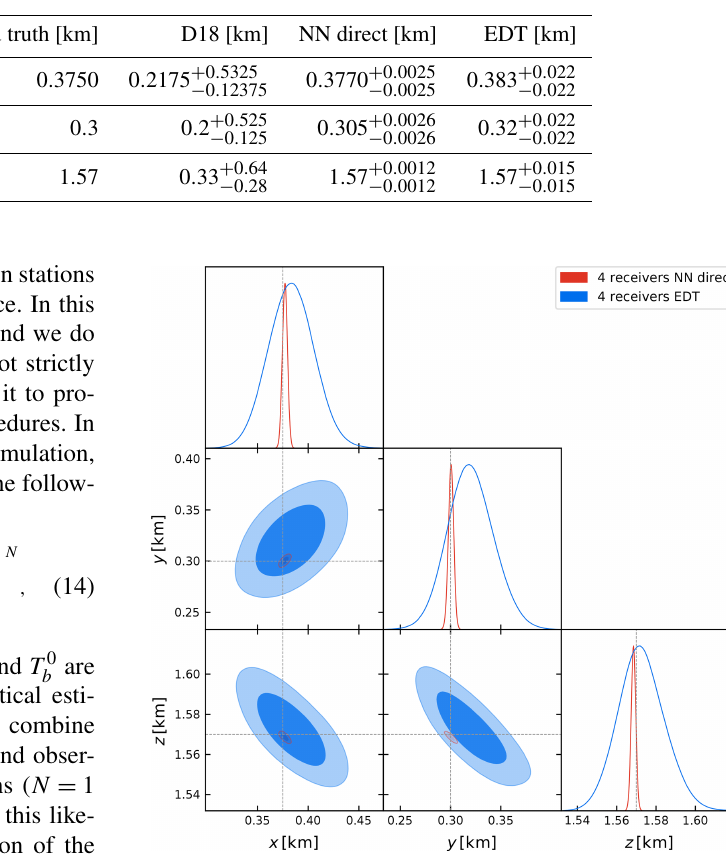
Figure 11. Comparison of the marginalized 68% and 95% per- cent credibility contours obtained with the EDT non-linear location method (in blue) and our proposed NN direct generative model (in red) described in Sect. 2.2.1, considering a seismic trace measured by the four receivers shown in Fig. 9. The dashed black lines indi- cate the source’s true coordinates at ( x,y,z ) = (0.375km, 0.3km,